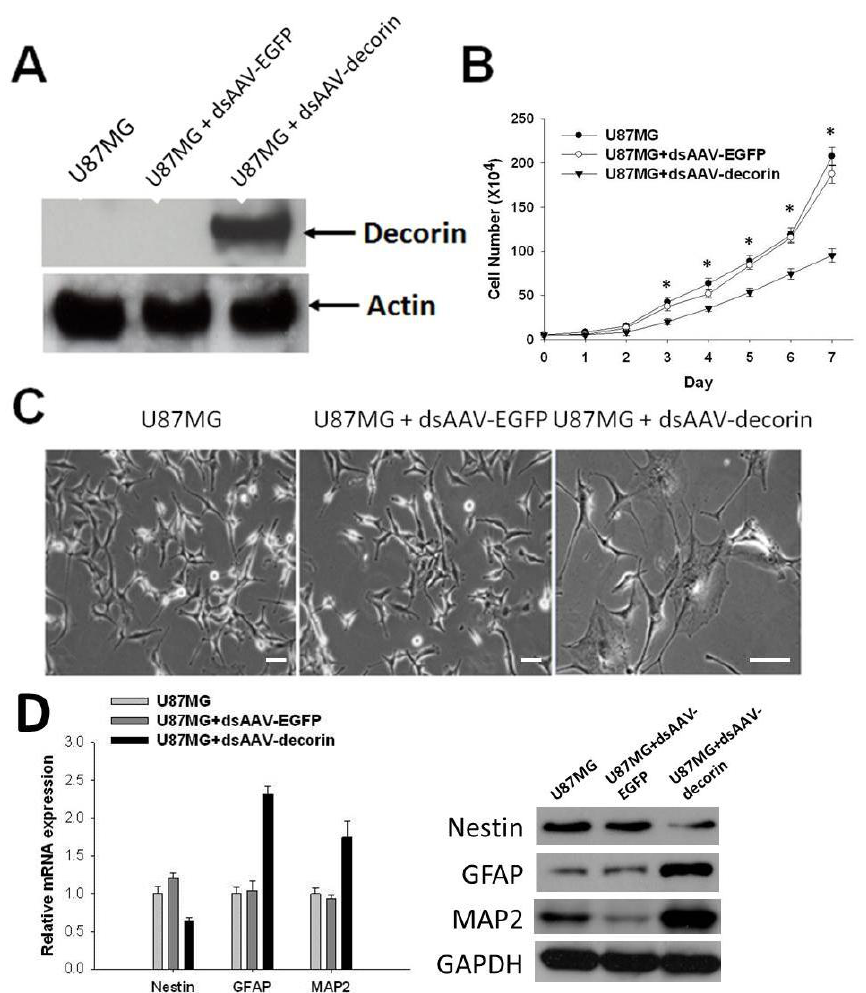
Figure 1. Decorin expression inhibits cells proliferation and induces changes of morphology of U87MG cells. ( A ) Western blot analysis of expression of dsAAV-encoded decroin in U87MG cells. No endogenous decorin proteins were detected in mock-transduced (U87MG) or dsAAV-EGFP cells while high-levels of ectopic decorin was seen in U87MG-dsAAV-decorin cells. Beta-actin was used as a loading control; ( B ) Inhibition of cell proliferation in dsAAV-decorin-transduced U87MG cells. The cell numbers of U87MG, stably transduced U87MG-dsAAV-EGFP and decorin were evaluated at the indicated times. Decorin expression suppresses cell growth in U87MG-dsAAV-decorin cells compared to Mock- or EGFP-transduced U87MG cells; ( C ) Decorin induced significant changes of morphology of U87MG-dsAAV-decorin cells as compared to controls; ( D ) mRNA and protein expression levels of Nestin, GFAP and MAP2 were detected in U87MG, U87MG-dsAAV-EGFP and decorin cells. Data are representative of three independent experiments. * p < 0.05; Scale bar: 20